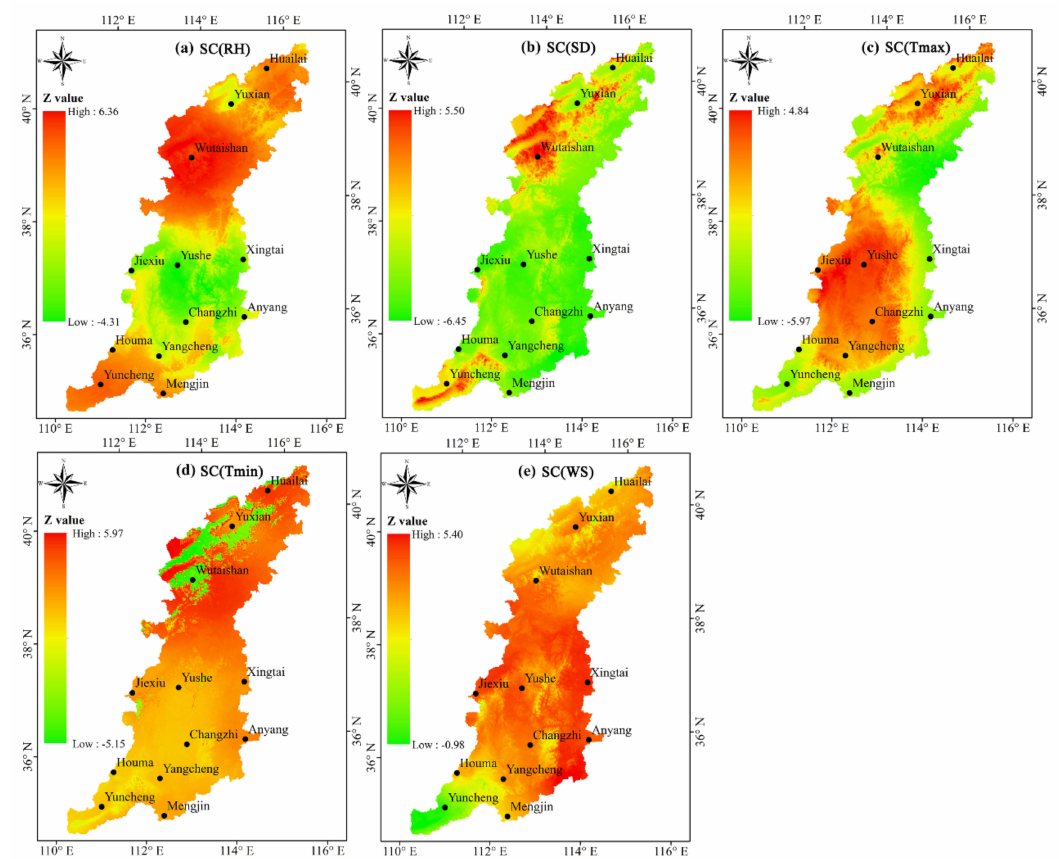
Figure 9. Z values of TFPW MK trend tests of the sensitivity coefficients of climatic factors during 1973–2016. ( a ) SC(RH), ( b ) SC(SD), ( c ) SC(Tmax), ( d ) SC(Tmin), ( e )